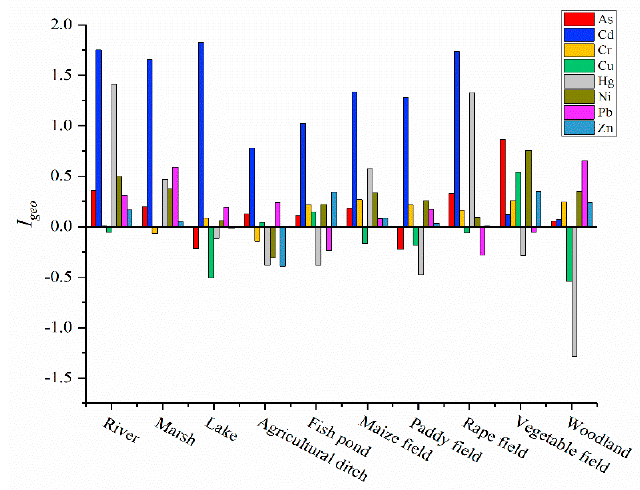
Figure 2. Geoaccumulation index ( I geo ) of eight heavy metals in different landuse types in the wetland.